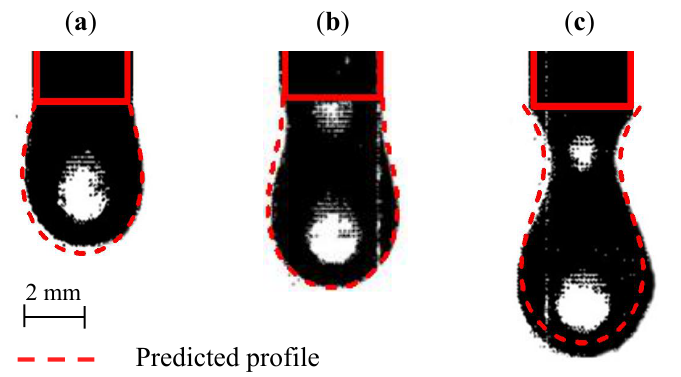
Figure 8. Droplet profile predictions. The pictures in black and white are from experiments [35], and the red dashed lines are predicted results: ( a ) t = 2092 ms, ( b ) t = 2990 ms, ( c ) t = 3075 ms.